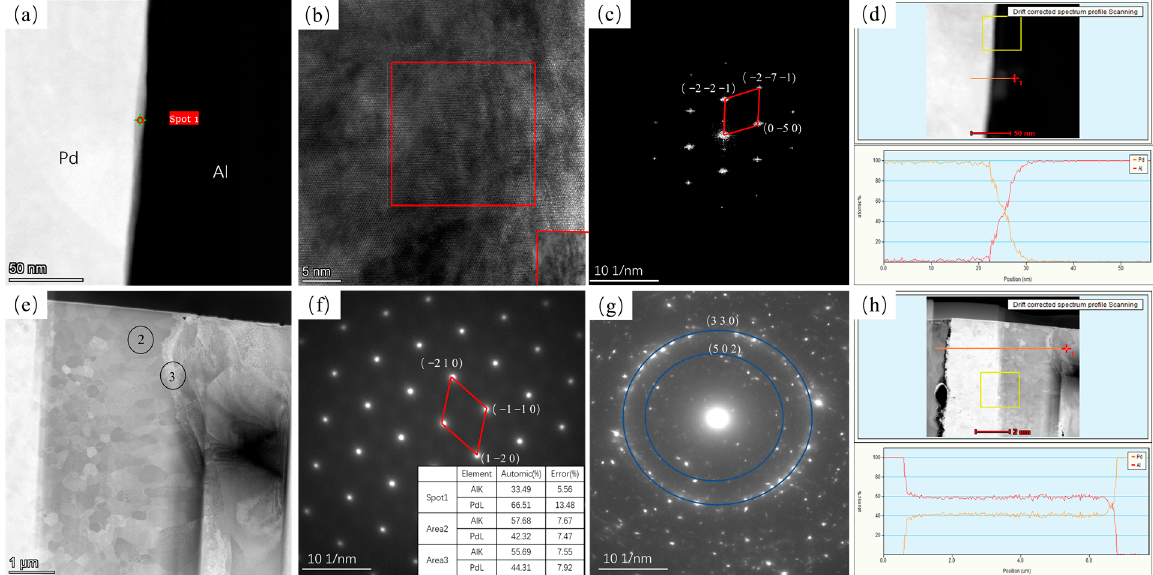
Figure 9. TEM plots of Pd/Al composite wires annealed at 350 °C for different times and their SEAD plots. ( a ) HAADF plot at 5 s, ( b ) high-resolution plot of spot 1 in ( a , c ) FFT transform of the red region in ( b , d ) EDS line sweep at 5 s, ( e ) HAADF plot at 1080 s, ( f ) SAED plot of spot 2 in ( e , g ) SAED plot of spot 3 in ( e ) and EDS results for each position, and ( h ) EDS line sweep at 10,800 s. Table 1. Interfacial intermetallic compounds generated under different annealing conditions for Pd/Al composite wires.